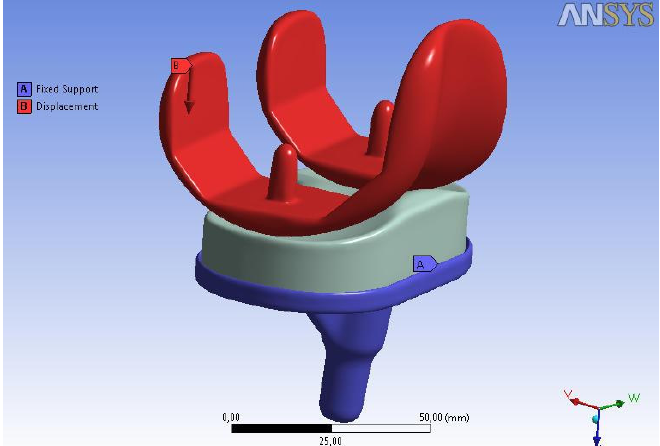
Figura 8: Condizioni al contorno: in blu il piatto tibiale bloccato, in rosso la componente femorale sulla quale è stato imposto lo spostamento verticale. Figure 8: Boundary conditions: fixed tibial support in blue, femoral component in red where vertical displacements are